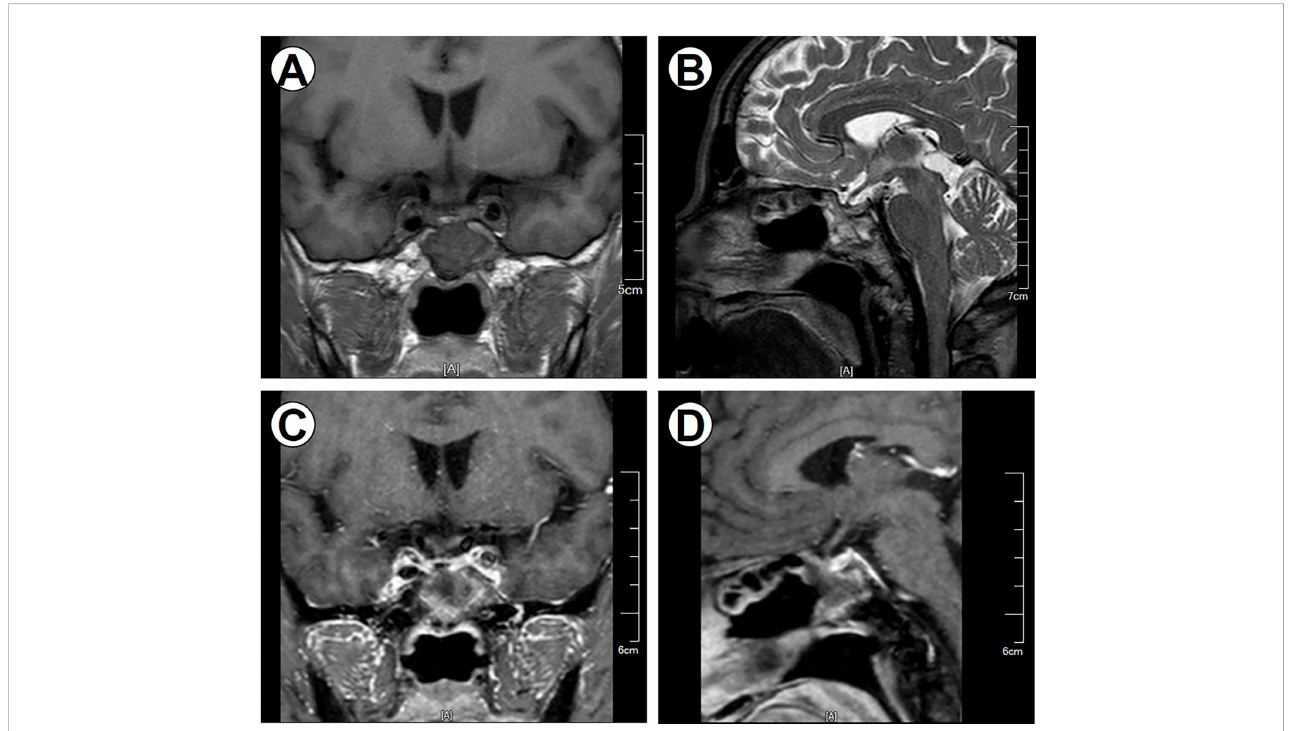
FIGURE 4 Postoperative MRI imaging data. Postoperative MR images demonstrate no regrowth of the tumor. (A) Coronal noncontrast T1-weighted image. (B) Sagittal T2-weighted image. (C) Coronal contrast T1-weighted image. (D) Sagittal contrast T1-weighted